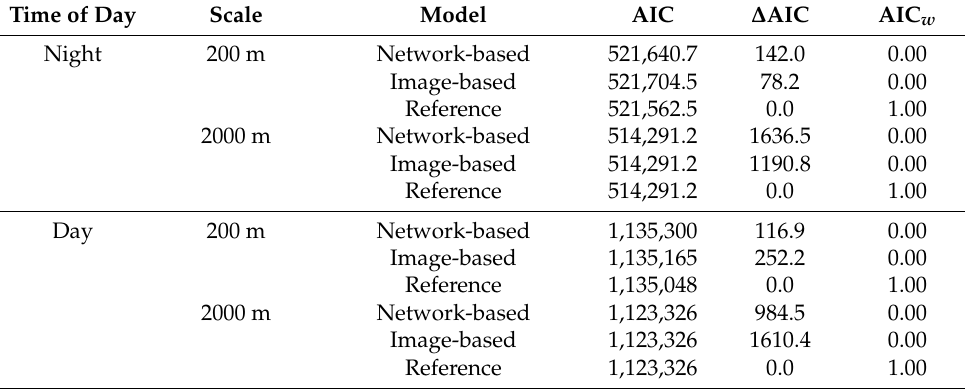
Table 4. Comparison of generalized linear mixed-effects models describing the habitat selection of grizzly bears based on road classification method, time of day and scale using Akaike information criteria scores (AIC), where lower AIC scores indicates better model fit within a group. ∆ AIC is the difference between the AIC score of that model and the lowest AIC score of the group. AIC w is the AIC weight (0–1 possible), an indication of the probability that a given model is the best model of the group. Sample sizes: Night = 21 grizzly bears (23,003 “used” locations), Day = 23 grizzly bears (56,575 “used”